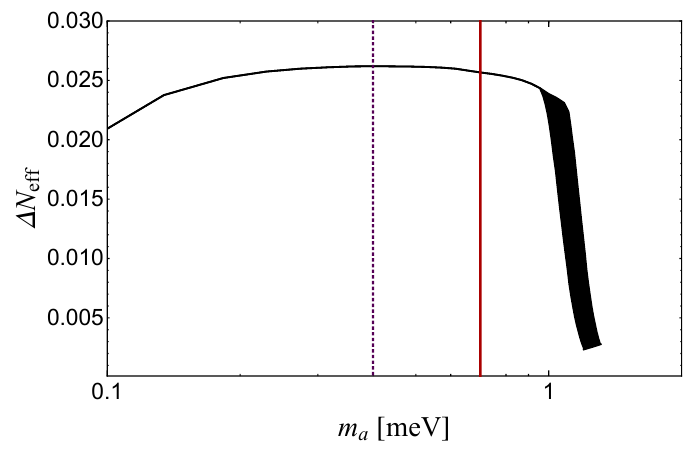
Figure 5 . The contribution of the QCD axion to e(cid:11)ective neutrino species as a function of m a based on the model (3.1) with n inf = 2, where the instantaneous reheating is assumed. The width of the black band becomes broader at m a & 1 meV corresponding to the uncertainties of (cid:24) (cf. eq. (3.15)). The predicted (cid:1) N e(cid:11) also sharply drops at m a & 1 meV because the required in(cid:13)ation scale is so low that axions are not thermalized. The slight decrease at the lower end of the mass is due to the increase of f a relative to the reheating temperature. The vertical dotted and solid lines represent sensitivity reach of MADMAX and TOORAD,